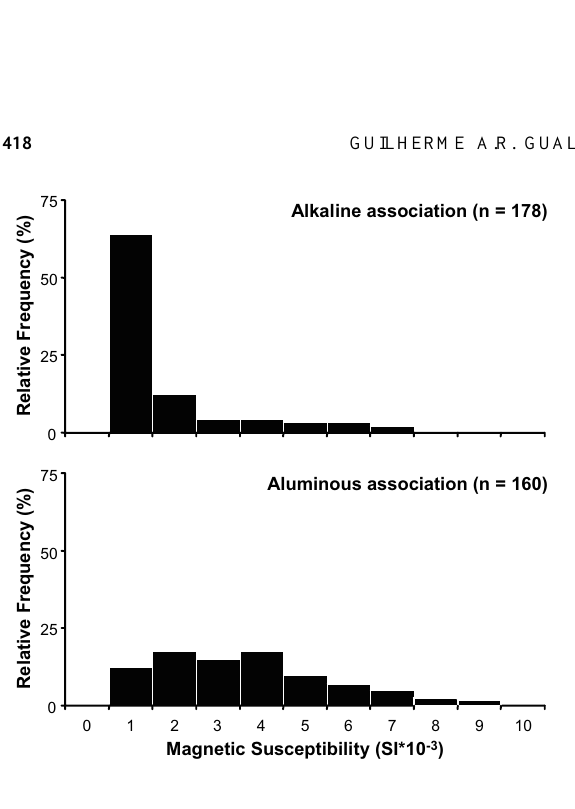
Fig. 5 – Histograms showing the variation in magnetic susceptibility forrepresentativesamplesoftheSerradaGraciosaA-typeGranitesand Syenites, southern Brazil. N is the total number of individual measure- ments. Notice the clear difference in magnetic susceptibility between the magnetite-bearing rocks of the aluminous association, when com- pared to the magnetite-free varieties of the alkaline